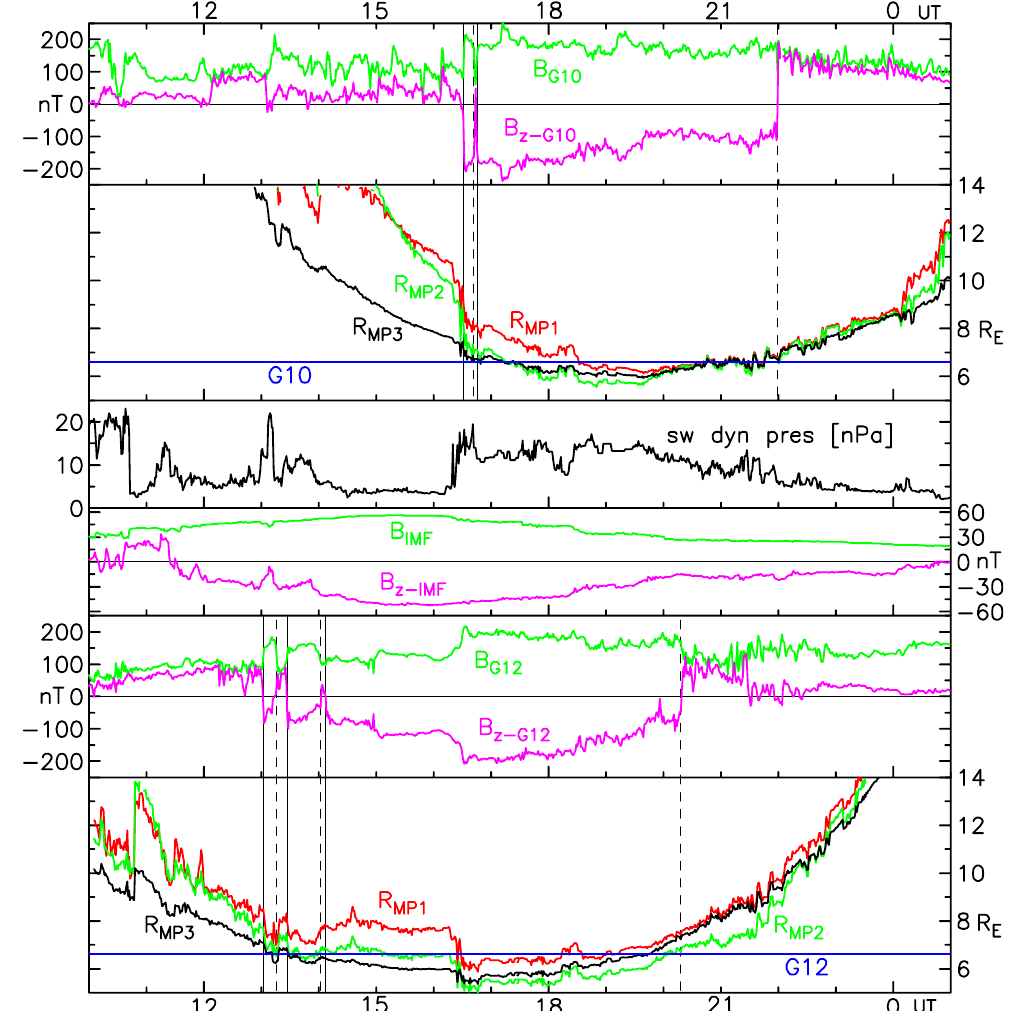
Fig. 5. 20 November 2003. Top panel: GOES 10 magnetic field observations: total value (green) and B z in GSM coordinates (lilac). Panel 2: model magnetopause locations for angular directions of GOES 10 position: MP1 in red (Shue et al., 1998), MP2 in green (Lin et al., 2010), and MP3 in black (new model); G10 trajectory: blue line. Panel 3: solar wind dynamic pressure. Panel 4: IMF total value (green) and B z (lilac). Panel 5: GOES 12 magnetic field: total value (green) and B z (lilac). Bottom panel: model magnetopause locations for angular directions of GOES 12 position: MP1 in red ( Shue et al., 1998), MP2 in green (Lin et al., 2010), and MP3 in black (new model); G12 trajectory: blue line. Solid vertical lines mark the time of observed outbound magnetopause crossings; dashed lines mark inbound crossings. Interplanetary data from ACE